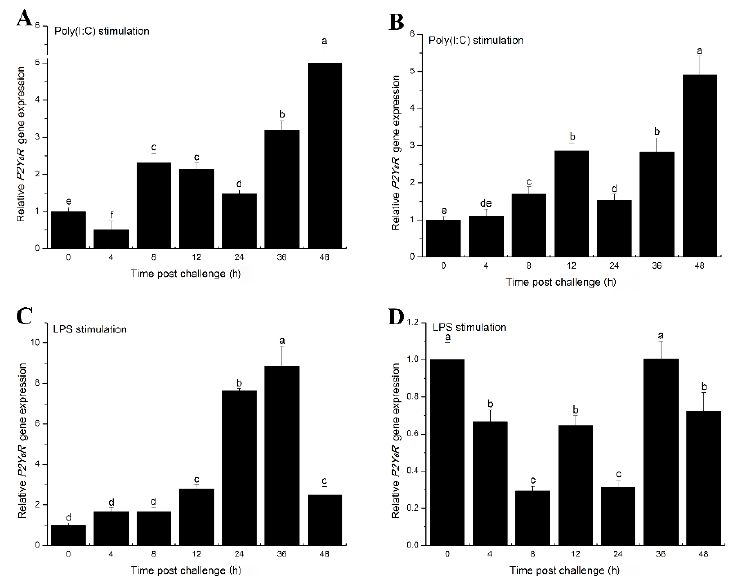
Figure 4. P2Y 6 receptor gene expression after inflammatory challenges in Japanese flounder immune cells. Expression of P2Y 6 receptor mRNA in response to poly(I:C) ( A ) and ( B ) and lipopolysaccharides (LPS) ( C ) and ( D ) stimulations in Japanese flounder head kidney macrophages ( A ) and ( C ) and peripheral blood leukocytes ( B ) and ( D ) relative to housekeeping gene β -actin was determined by quantitative real-time PCR. The expression of P2Y 6 R in response to inflammatory challenges was normalized to untreated control cells (set to 1). Data are presented as means ± standard deviations ( n = 3). Groups marked by different lowercase letters above each bar represent a significant difference at p < 0.05. The same letters indicate no significant difference between groups.